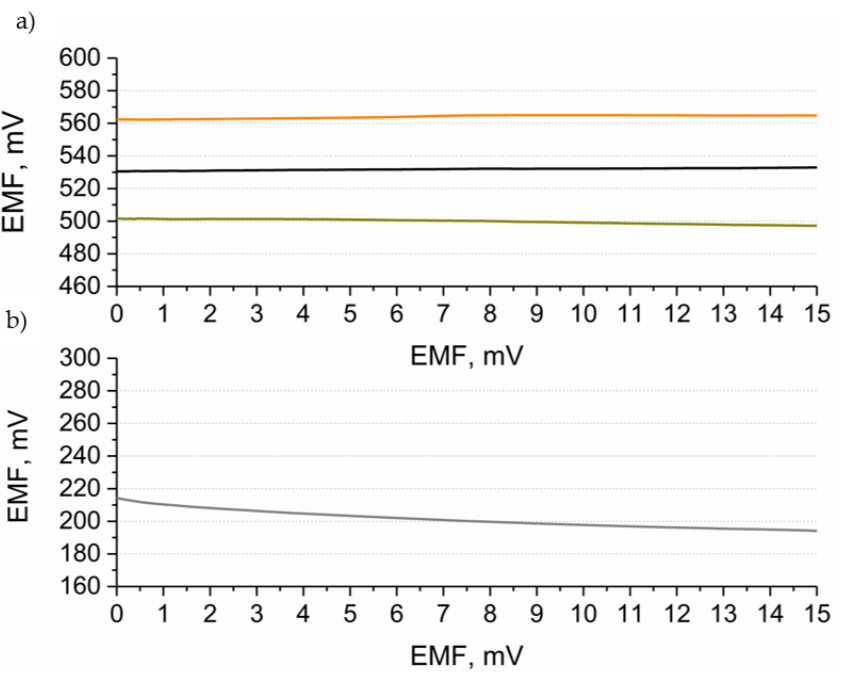
Figure 5. Potentiometric response recorded for ( a ): GCD/hCeO 2 /K + -ISM (dark yellow line), GCD/hCeO 2 + NTs/K + -ISM (black line) and GCD/hCeO 2 + POT/K + -ISM (orange line) electrode and ( b ): GCD/K + -ISM (grey line) electrode during 15 h-long measurement in 0.01 M KCl solution. The potential drift values were as follows: 0.086 mV/h, 0.095 mV/h, 0.24 mV/h